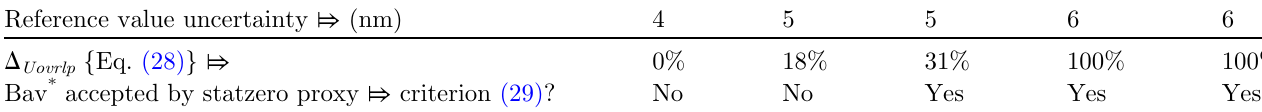
Table 15. Example 6 results (FAC-1, system D). Overlap of the con fi dence interval ★ with uncertainty of the reference , {Eq. values ( D Uovrlp